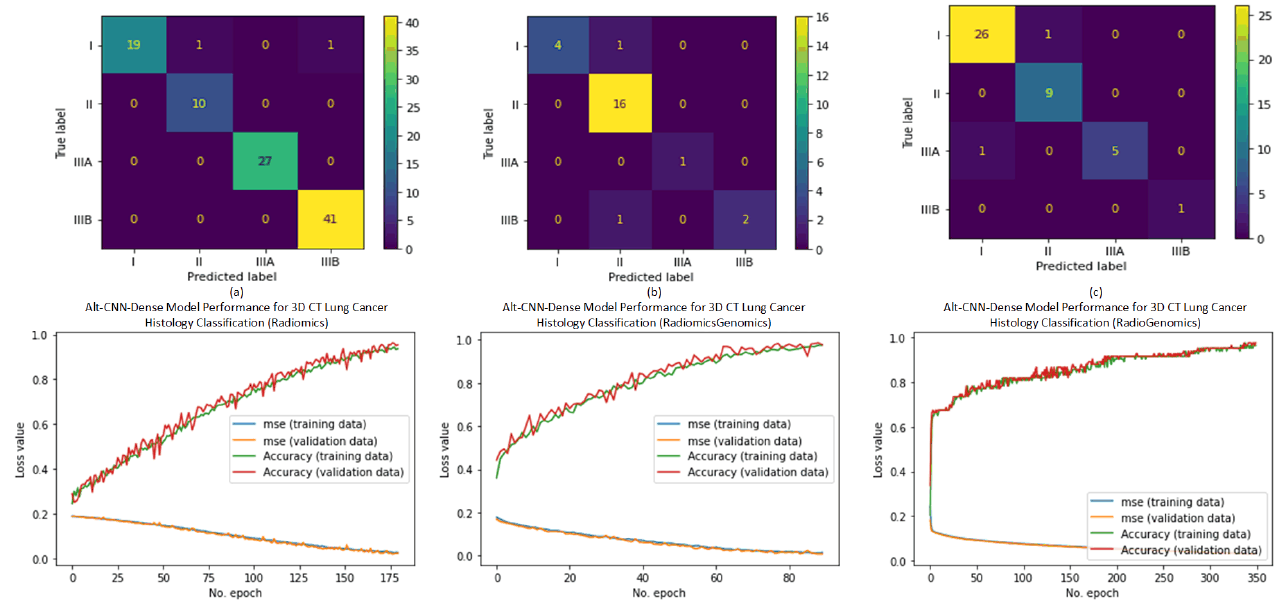
Figure 14. Summary of Staging results presenting confusion matrices and learning curves on three datasets ( a ) Radiomics ( b ) Radiomics Genomics ( c ) Radio Genomics. The learning curves present mean square error (mse) for training and testing and Accuracy for training and testing